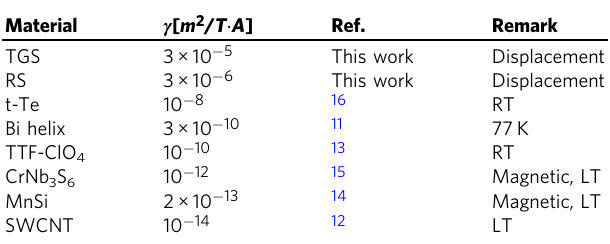
Fig. 5 Chirality dependence RS. Magnetochiral anisotropy (MChA, red balls) and dielectric constant (blue triangles) of L-RS (top panel, fi lled symbols) and D-RS (bottom panel, open symbols) as a function of temperature. Lines are guides to the eye. Frequency 50 kHz, electric fi eld 5 kV/m. Table 2 Values for the magnetochiral anisotropy parameter reported here and in the literature.